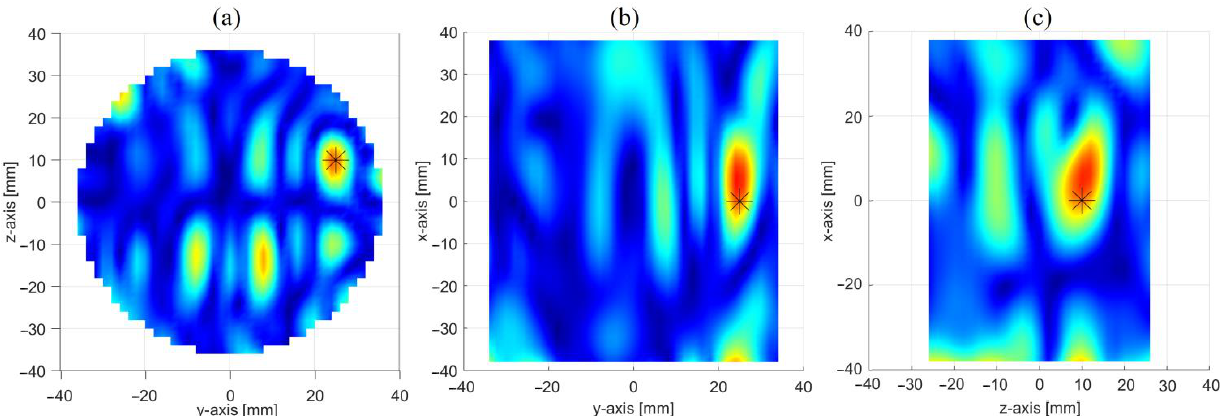
Figure 8. Reconstruction of the inclusion through the OSP-based approach: images in three orthogonal cut planes crossing the center of the inclusion (stars give the position of the inclusion) i.e., ( a ) x = 0 cm cut plane, ( b ) z = 10 cm cut plane and ( c ) y = 25 cm cut plane.